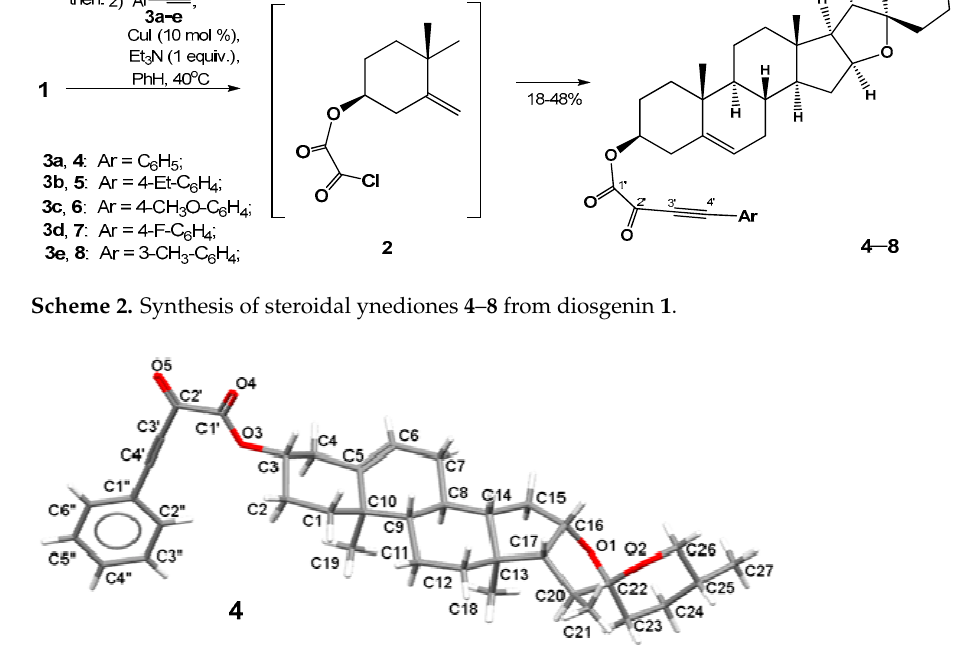
Figure 1. The molecular structure of compound 4 . The thermal ellipsoids are drawn at the 30% probability level.